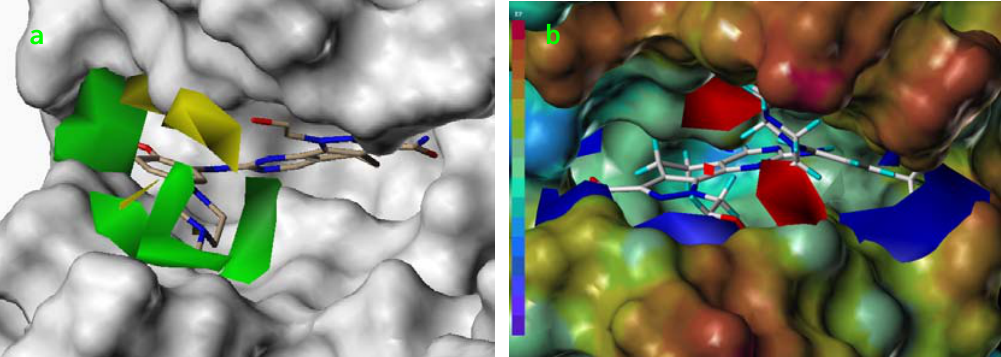
Figure 6. The CoMFA contour map of model 2 combined with compound 73 . ( a ) Steric field distribution on the background of protein surface; and ( b ) electrostatic field distribution on the background of electrostatic potential surface colored from purple to red owing to the increase of electron density. Green contours indicate regions where bulky groups increase activity, whereas yellow contours indicate regions where bulky groups decrease activity. Red contours suggest negative charge favoring activity, whereas blue contours suggest positive charge favoring